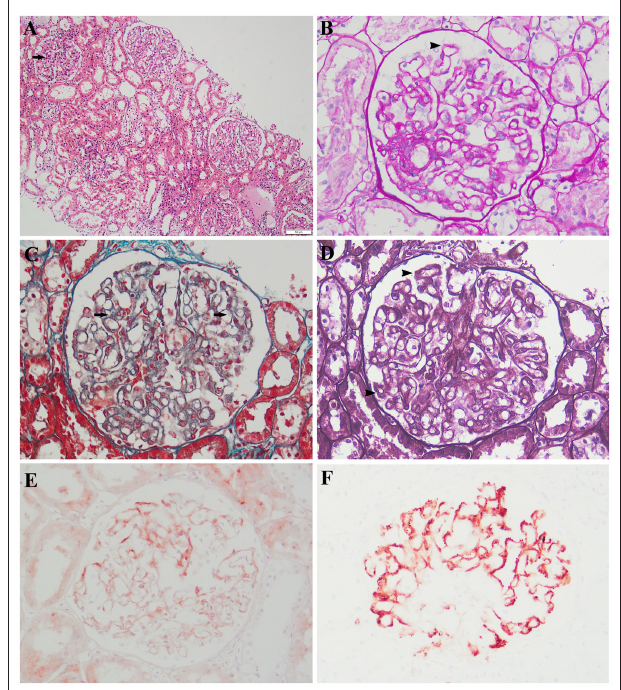
FIGURE 1 | Histologic and immunohistochemical features of renal lesions. (A) Segmental mesangial expansion (hematoxylin and eosin; original magnification, × 100). (B,D) Slight global glomerular basement membrane thickening (periodic acid–Schiff and Jones methenamine silver, respectively; original magnification, × 200). (C) Scattered fuchsinophilic deposits (Masson’s trichrome; original magnification, × 200). Immunohistochemical assay